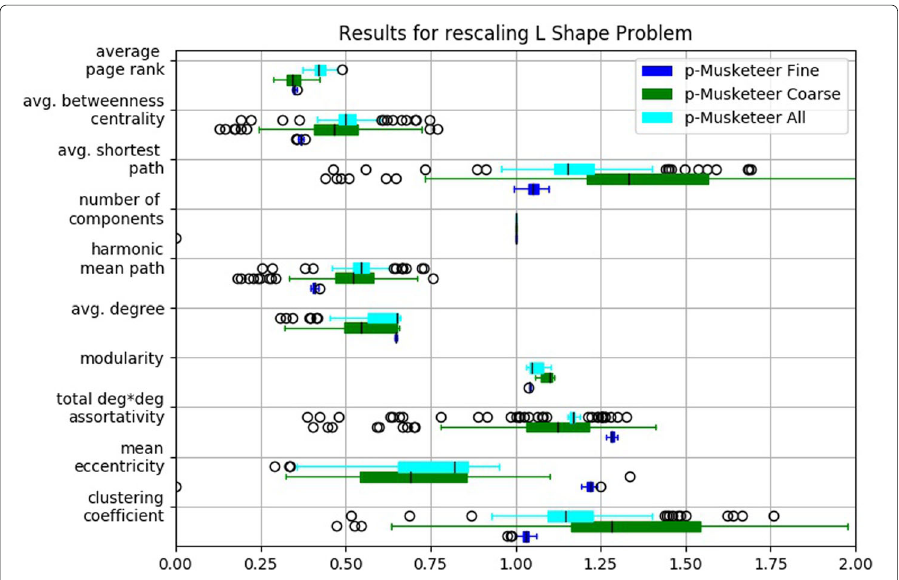
Fig. 22 Computational results on performance of planar Musketeer on graph for thermal L-Shape Problem with 3025 nodes and 8904 edges to at least 9000 nodes and 12000